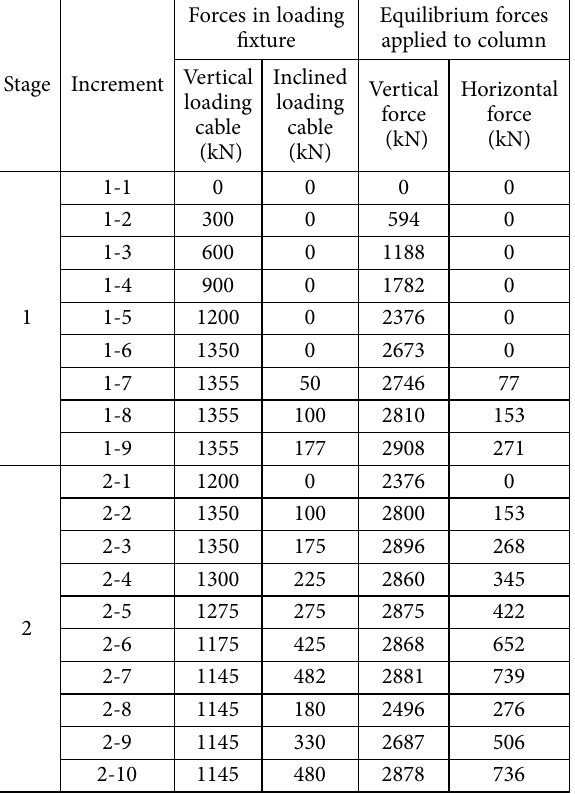
Table 2. Loading plan for type A connection test